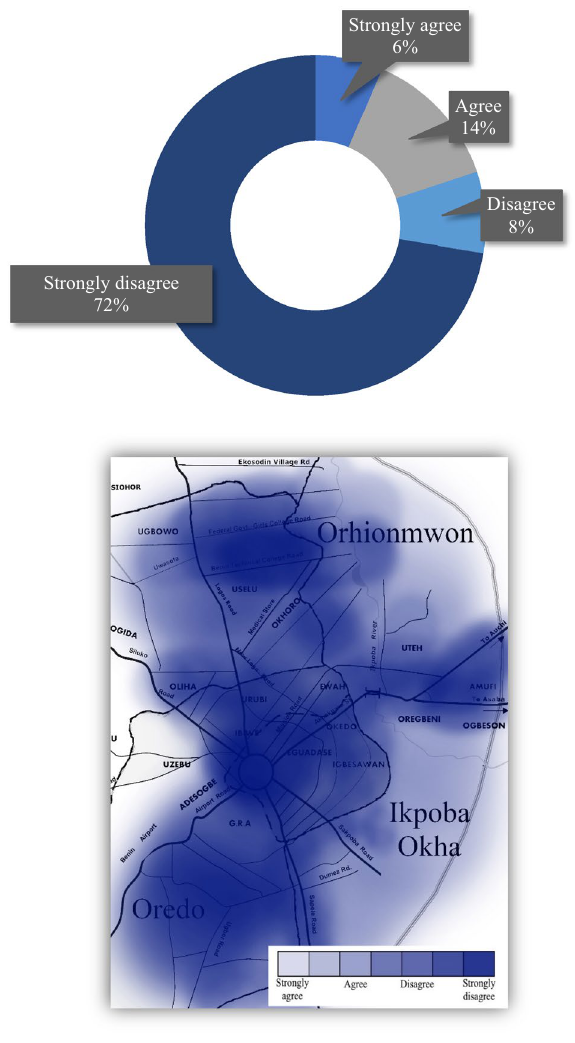
Figure 5. Perception that the authorities responsible for the GHG emissions have a sound knowledge of good practice: (top) graph, (bottom) mapped results.